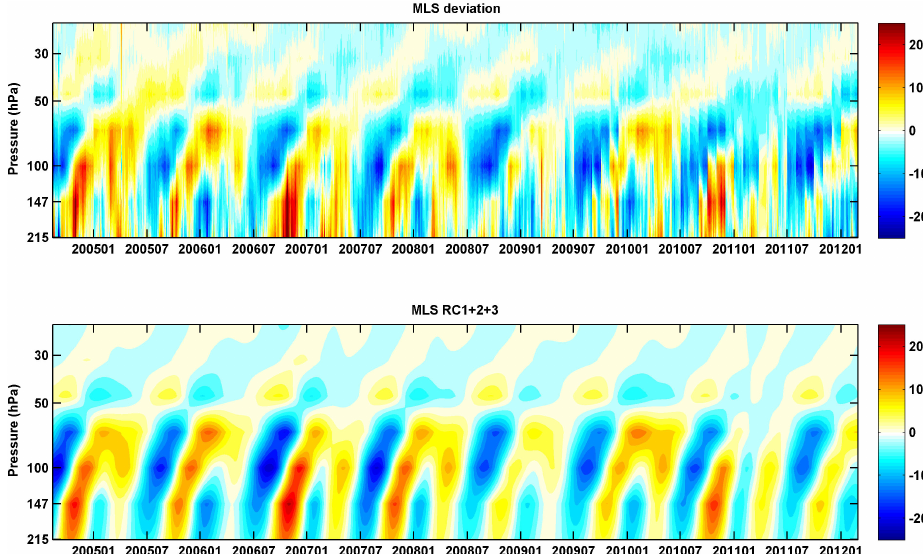
Fig. 12. (Top) daily MLS tropical (10 ◦ S–10 ◦ N) CO and (bottom) its reconstruction from the first three EEOF from August 2004 to Febru- ary